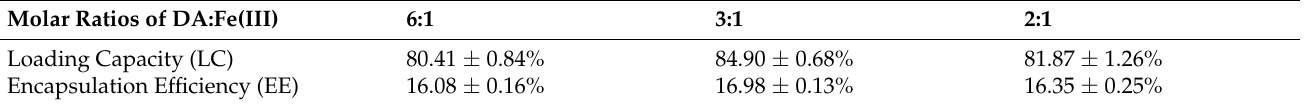
Table 1. Drug loading capacity of nano-system with different DA to Fe(III) molar ratios.